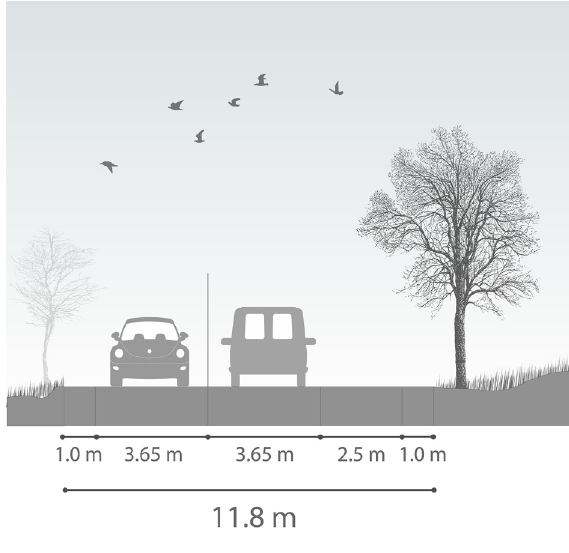
Fig. 10. Basic section of the proposed Transversal de las Américas. Lack of spaces for soft transport systems. Source: own compilation based on Agencia Nacional de Infraestructura (ANI)